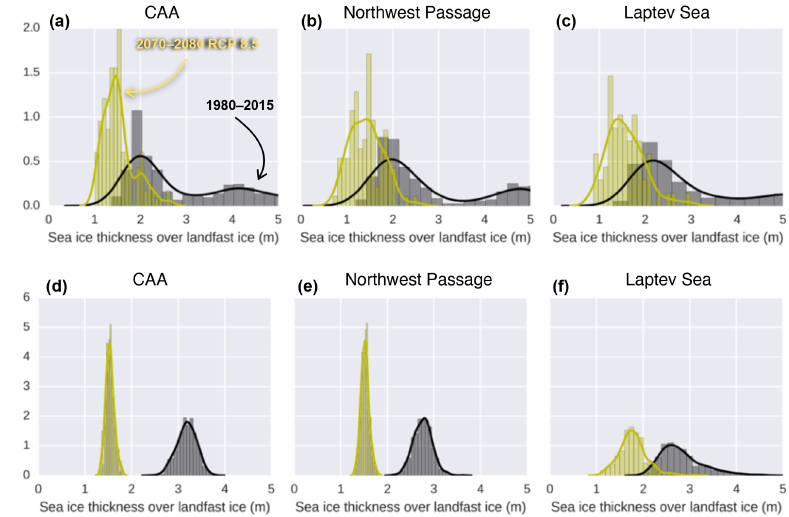
Figure 9. (a) Distribution (across simulations and years) of the annual maximum ice thickness averaged over landfast ice duration of more than 5 months over the CAA for the 1980–2015 period in black and the 2070–2080 period of the RCP 8.5 scenario in yellow. (b) Same as (a) but over the Northwest Passage. (c) Same as (b) but over the Laptev Sea. (d) – (f) Same as (a) – (c) but for the CESM-LE.